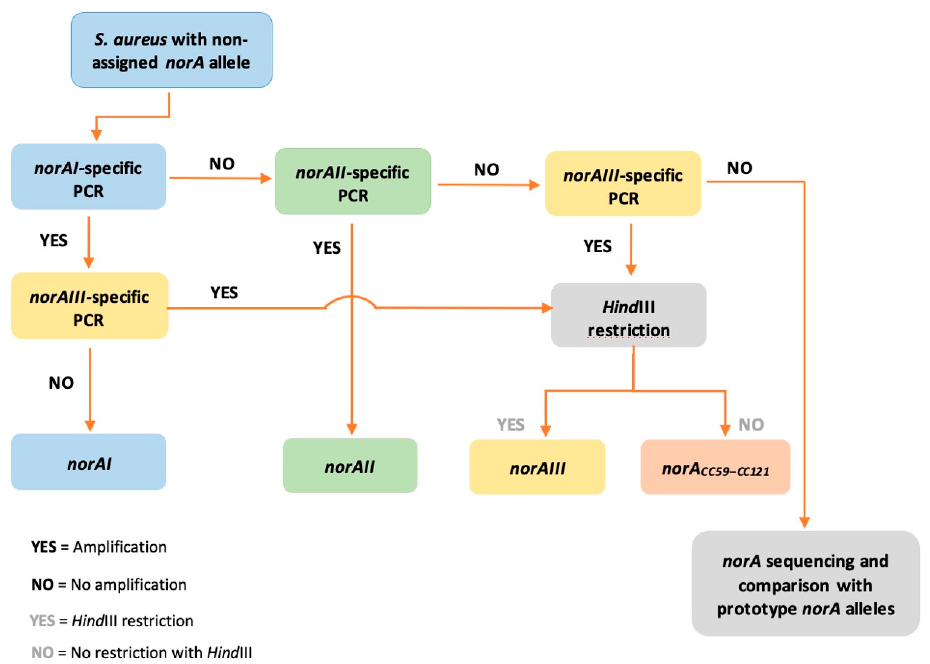
Figure 4. Proposed workflow for the rapid screening of S. aureus norA alleles.